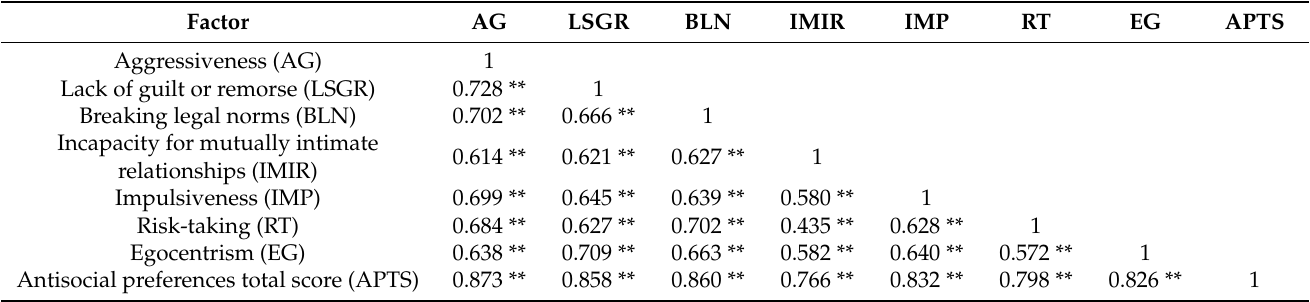
Table 6. Correlations between APS factors.